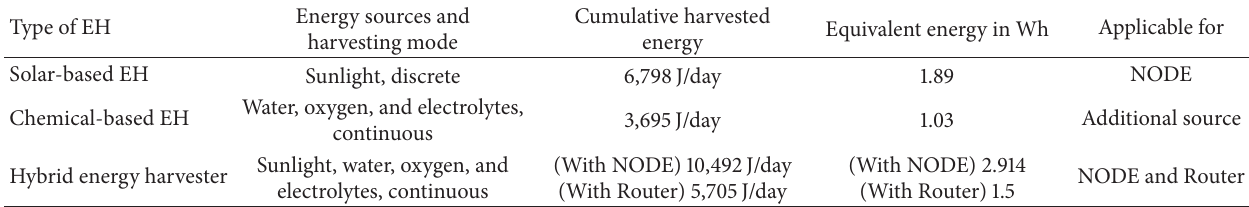
Table 5: Capabilities of the implemented energy harvesters at a